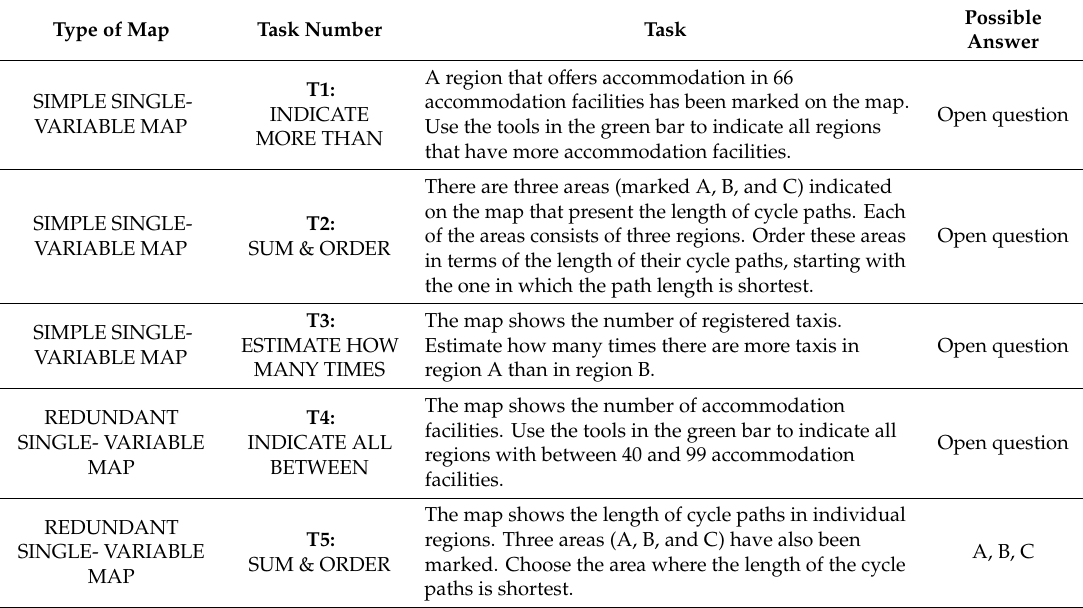
Table 2. Content of the tasks, the type of map used, and the method for providing